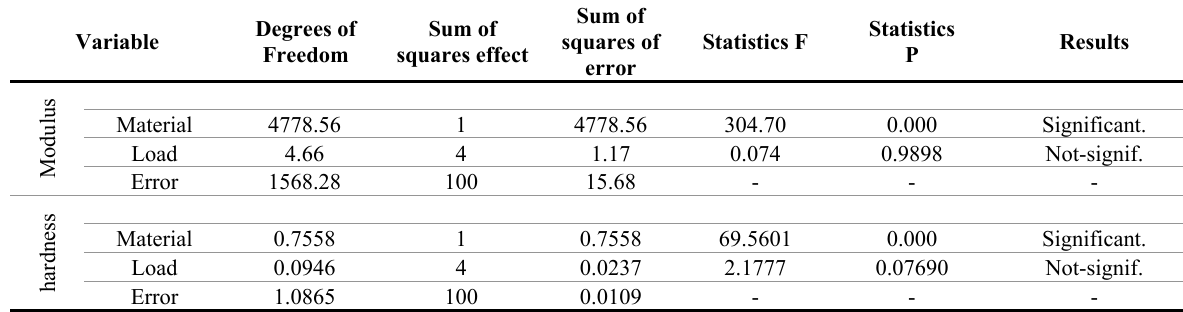
Table 5. Statistical analysis (ANOVA): elastic modulus and hardness. Variable